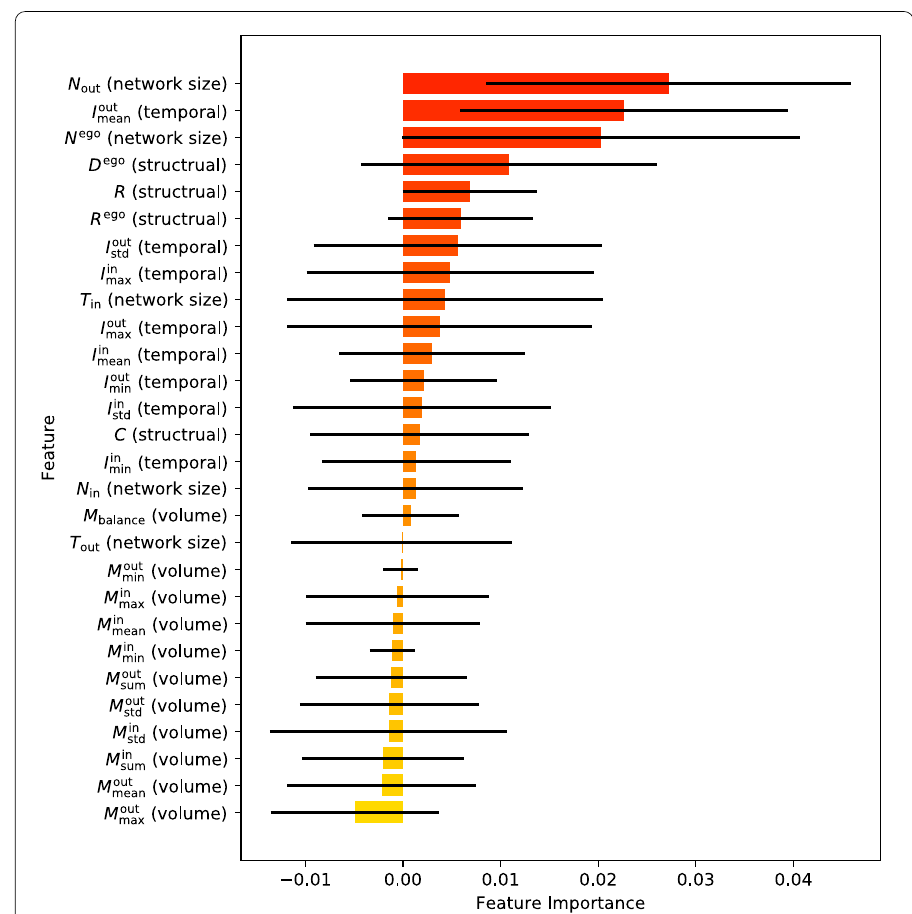
Figure 4 The means and variances of feature importance in the random forest model. The features are ranked by their permutation importance scores. Network size and structural features and temporal features scored highest while volume features do not provide much added information in the model